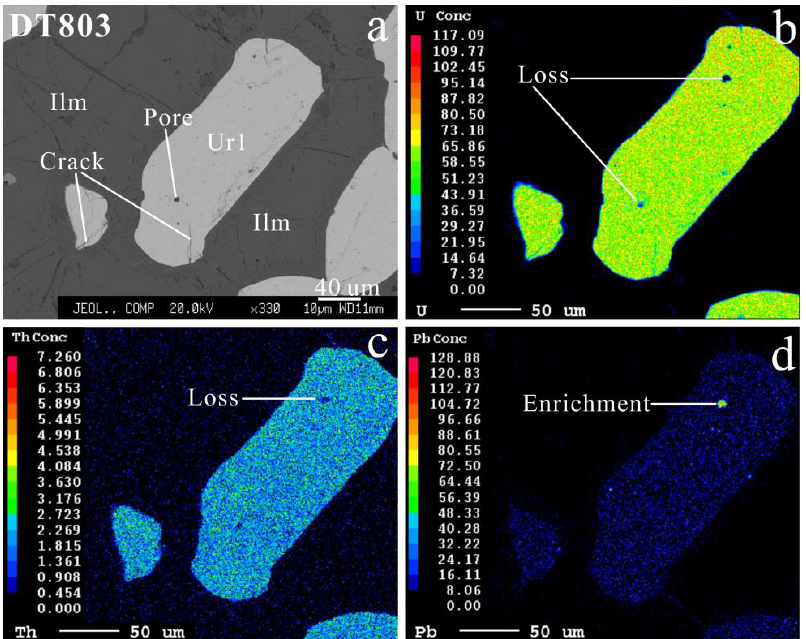
Figure 7. ( a ) BSE images and ( b – d ) X-ray element maps of the Ur1 uraninite grains showing intra- grain compositional homogeneity. Mineral abbreviations: Ur — uraninite; Ilm — ilmenite.